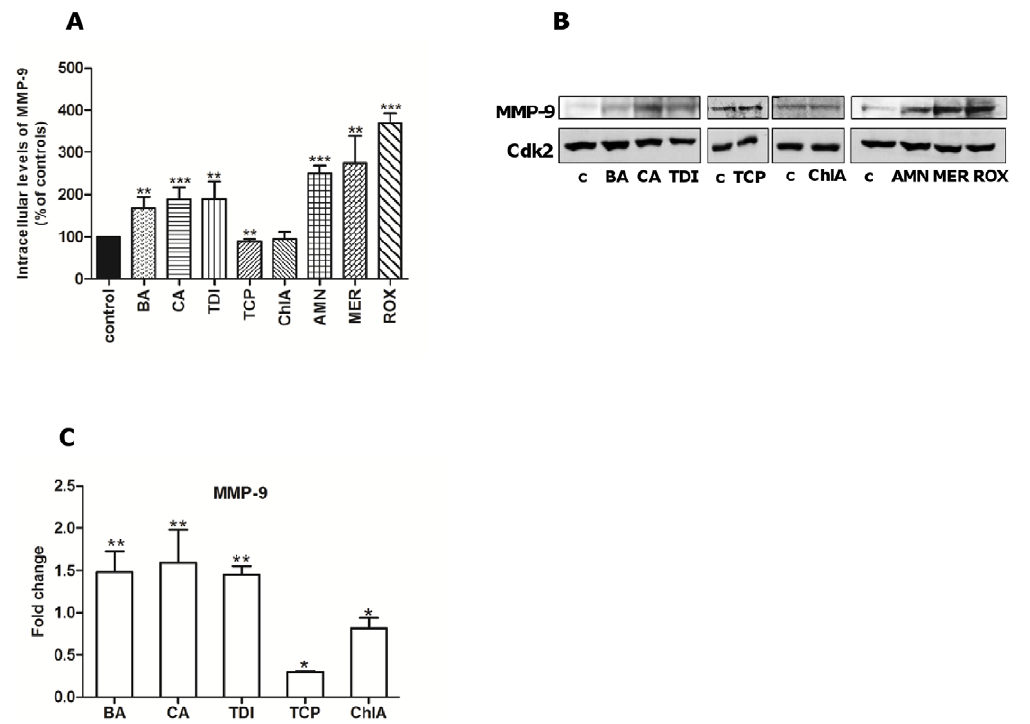
Figure 5. Male-specific pancreatic carcinogens induce MMP-9 expression in Panc-1 cells. Cells were treated with 10 m M TCP, ChlA, BA, CA, TDI, AMN, MER or ROX for 24 hours. ( A ) Densitometric analysis of intracellular MMP-9 levels. Level in untreated cells (control) was set to 100. ( B ) Representative Western blots of intracellular MMP-9 protein levels. ( C ) Cells were treated with 10 m M BA, CA, TDI, TCP or ChlA for 24 hours. Samples were analyzed by Real Time RT-PCR using primers shown in Table 2. Results are presented as mean 6 SD, n=3 and control levels were set to one. *significantly different from controls (*p , 0.05, **p , 0.01, ***p , 0.001).